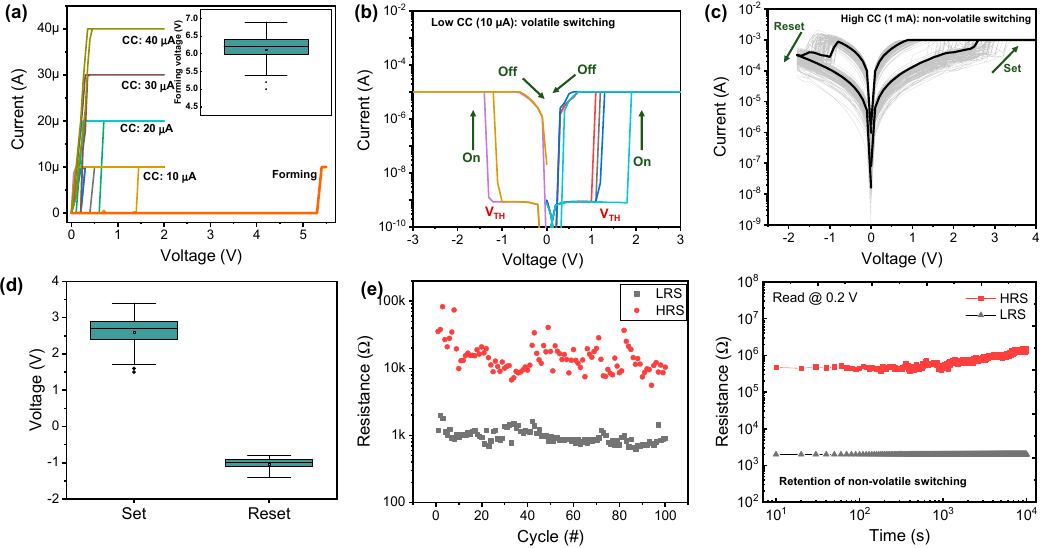
Figure 2. Volatile and non-volatile switching of Cu/AlN/TiN device. ( a ) Voltage sweep with different CCs from 10 µ A to 40 µ A to distinguish the volatile and non-volatile switching and the distribution of forming voltage in inset; ( b ) Volatile I–V and ( c ) non-volatile I–V characteristics; ( d ) Set and reset distribution and ( e ) endurance for non-volatile switching; ( f ) Retention property of non-volatile switching in the LRS and HRS for 10000 s.